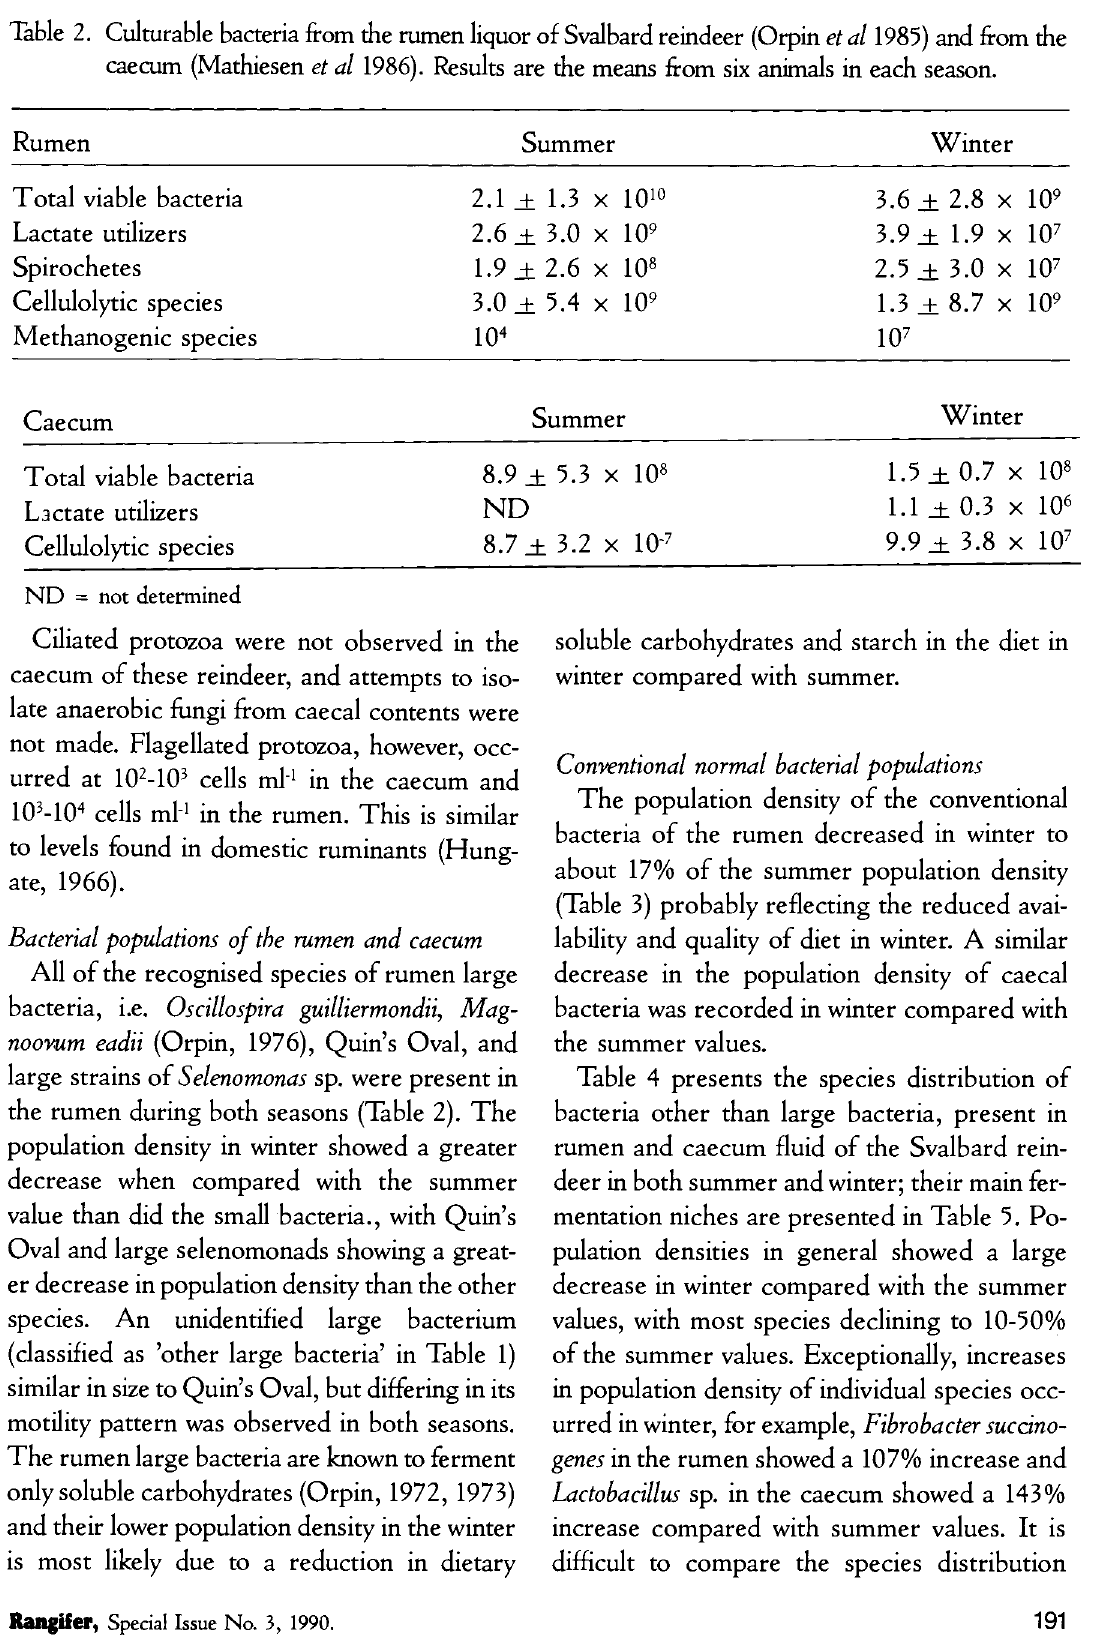
Table 2. Cultivable bacteria from the rumen liquor of Svalbard reindeer (Orpin et al 1985) and from the caecum (Mathiesen et al 1986). Results are the means from six animals in each